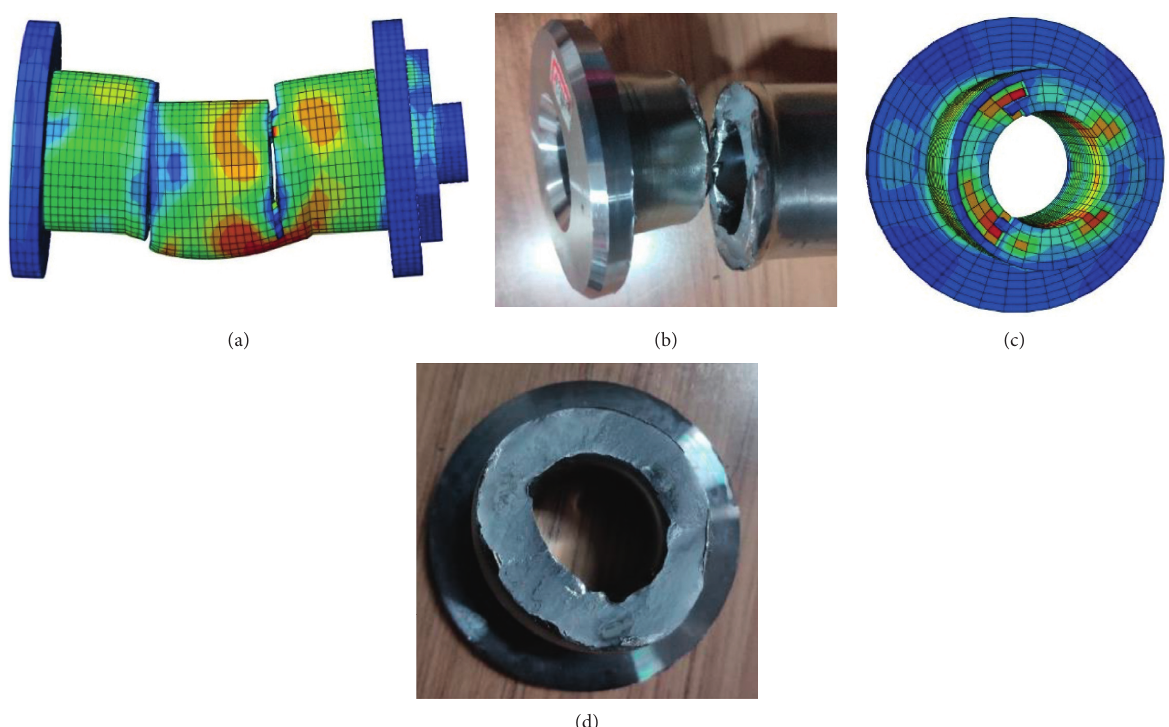
Figure 11: Comparison of test and simulation result. (a) Simulation result of fuse pin. (b) Test results of fuse pin. (c) Cut view of simulation result of fuse pin. (d) Cut view of fuse pin after